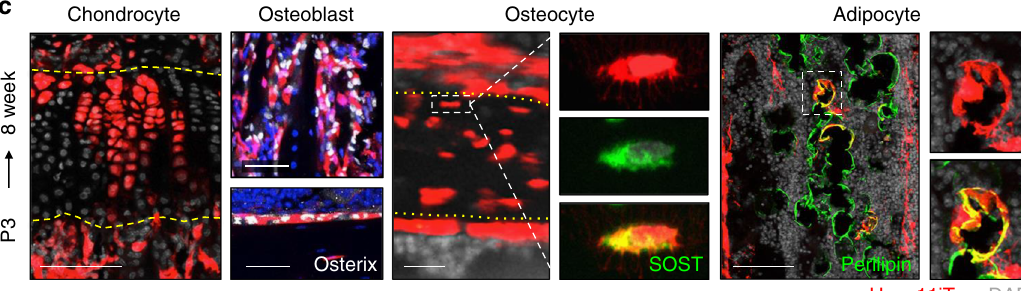
Fig. 4 Hoxa11- lineage contributes to all skeletal/mesenchymal cell types. a – b Pregnant dams received tamoxifen at E13.5 and resulting Hoxa11eGFP;Hoxa11- CreER T2 ;ROSA-tdTomato mice were chased to ( a ) 8 weeks or ( b ) 1 year. c P3 pups received tamoxifen and Hoxa11eGFP;Hoxa11-CreER T2 ;ROSA-tdTomato mice were chased to 8 weeks. All images, Hoxa11 lineage-labeled cells (Hoxa11iTom, red). Shown are chondrocytes with characteristic columnar morphology at distal end of growth plate, osteoblasts stained with Osterix (white) on trabecular (top) and endosteal bone (bottom), osteocytes within the cortical bone stained with SOST (green), and bone marrow adipocytes stained with Perilipin (green). Dashed yellow lines mark upper and lower boundaries of growth plate, dotted yellow lines mark periosteal and endosteal boundaries of cortical bone. White dashed boxed region of single ( a , c ) or multiple ( b ) osteocytes (s) magni fi ed to right. White dotted box of single adipocyte magni fi ed to right. In all images, gray or blue: DAPI. Scale bars: (chondrocyte and adipocytes images) 100 μ m, (osteoblast and osteocyte images) 50 μ m, ( b , SOST) 25 μ